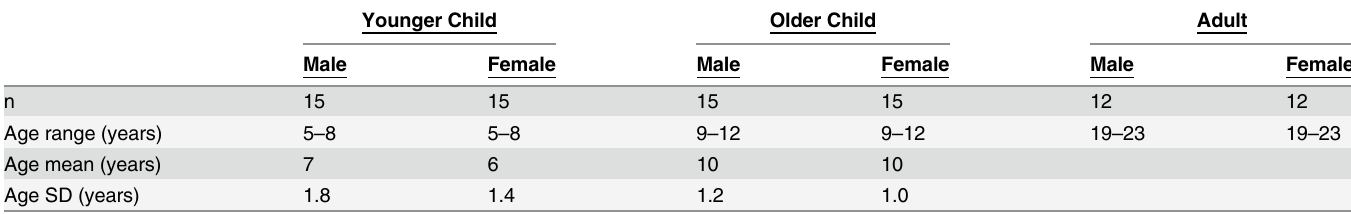
Table 2. Faces used for